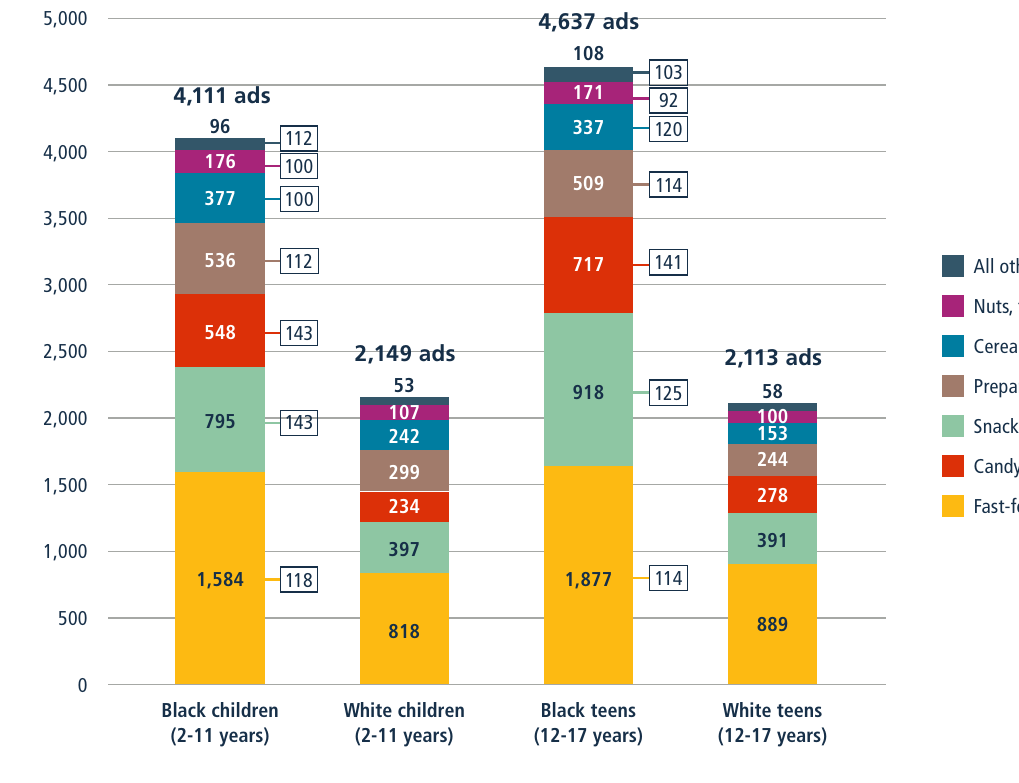
FIGURE 17. BLACK AND WHITE YOUTH’S EXPOSURE TO ADVERTISING ON ALL TV PROGRAMMING BY CATEGORY